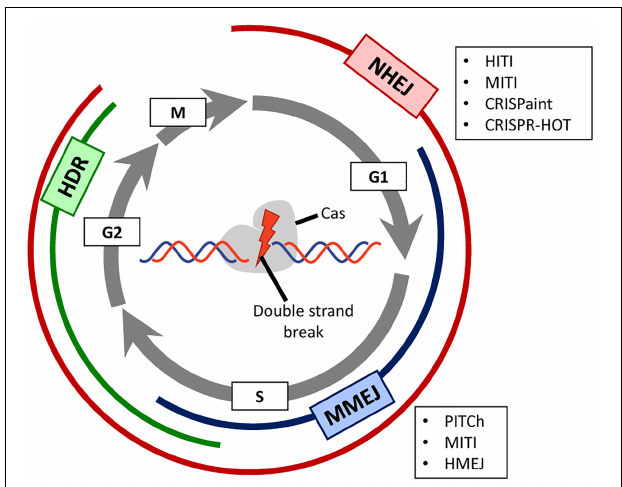
FIGURE 1 | Prevalence of DNA repair pathways during the different stages of the cell cycle. A Cas-containing RGN is directed to a target site in the genome consisting of a PAM and a sequence complementary to the spacer portion of the guide RNA. Depending on the RGN type, the produced double-stranded DNA breaks (DSBs) present either blunt or staggered ends. Depending on the phase of the cell cycle (displayed as gray circular arrows), different DNA repair mechanisms, each of which with their own set of factors, will be activated for repairing the site-specific DSB. Non-homologous end joining (NHEJ, in red) is active during the whole cell cycle except in mitosis, and homology-directed repair (HDR, in green) is mainly active during the S/G2 phases. Microhomology-mediated end joining (MMEJ, in blue) is an alternative NHEJ pathway mainly active during the G1/early S phases. This pathway shares some features with canonical NHEJ and HDR but uses a different molecular machinery and short homology sequences to repair the DNA break. In post-mitotic cells, the mostly error-free, HDR pathway is not active. For this reason, there are several innovative CRISPR/Cas-based strategies (boxed acronyms) that rely instead on NHEJ or MMEJ to allow for precise gene knock-in in non-dividing